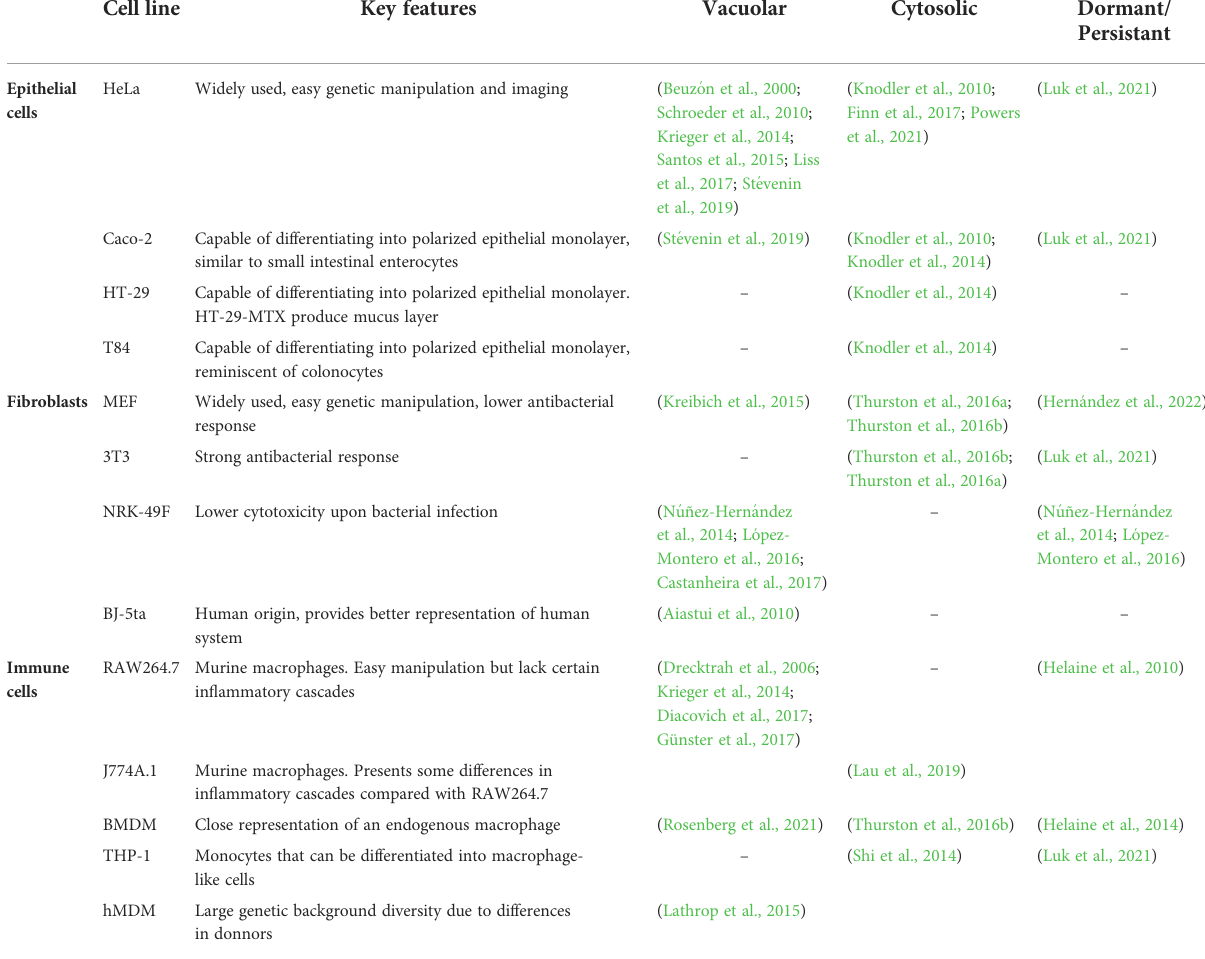
TABLE 1 Cell lines commonly used for Salmonella analysis of intracellular lifestyles and main references exploring speci fi c intracellular niches. Cell